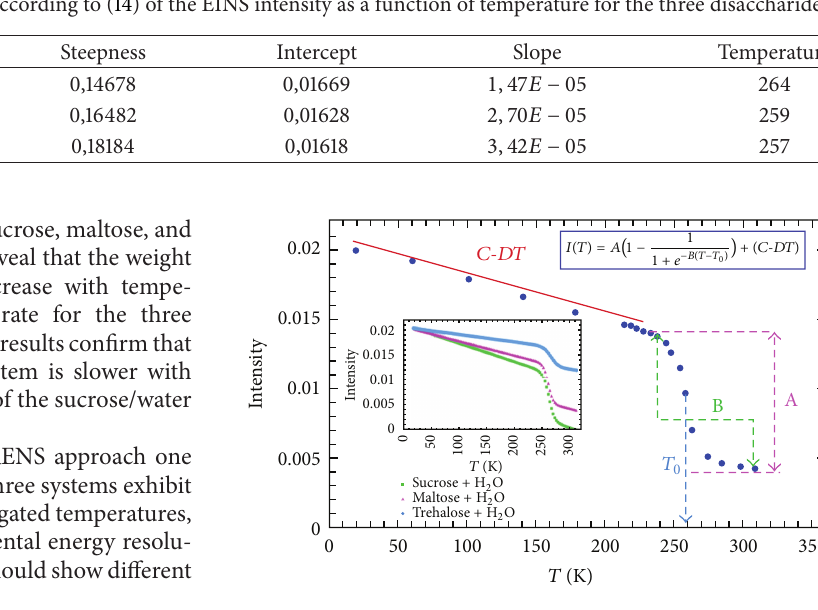
Figure 4: Intensity profile, obtained as sum for all the wavevector values, for maltose/H 2 O versus temperature with the fitting result according to